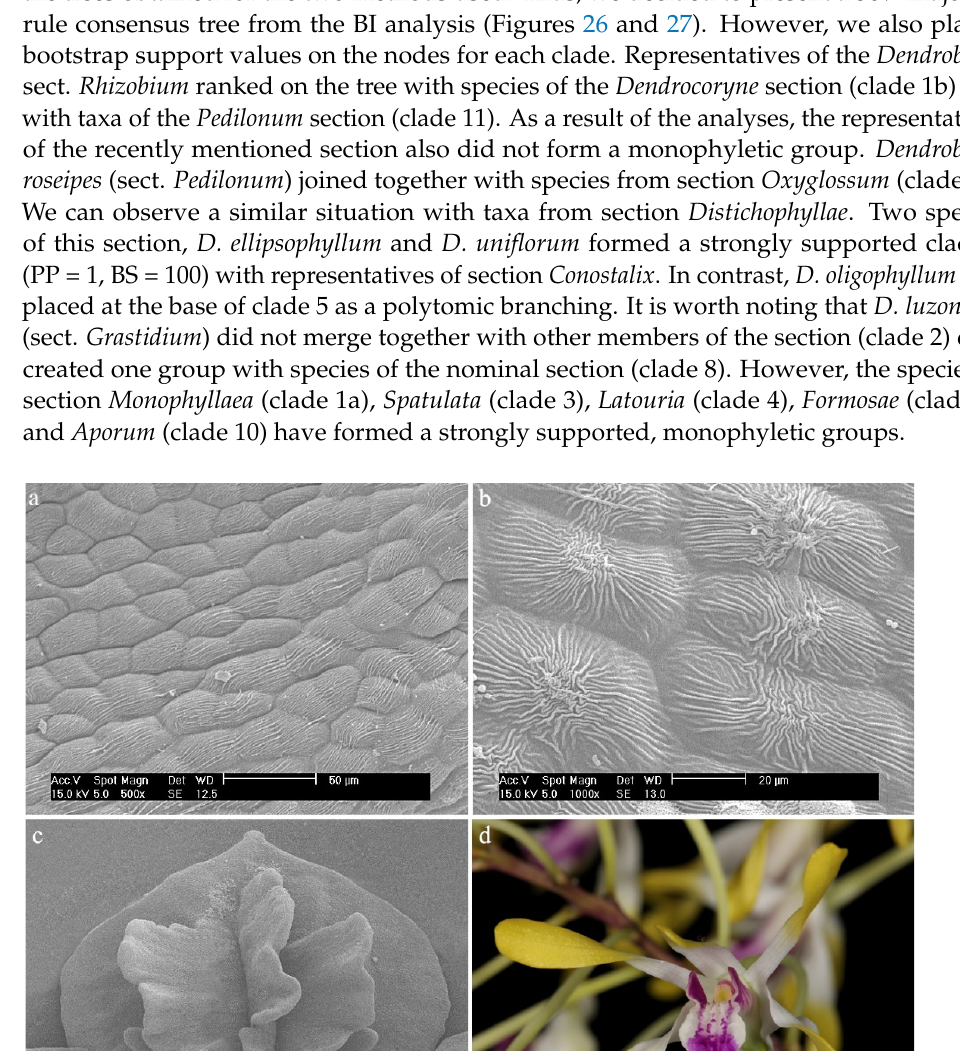
Figure 24. Dendrobium alaticaulinum P.Royen.: ( a ) the hypochile part of the labellum; ( b ) the mes- ochile part of the labellum; ( c ) flower (photo by John Varigos).